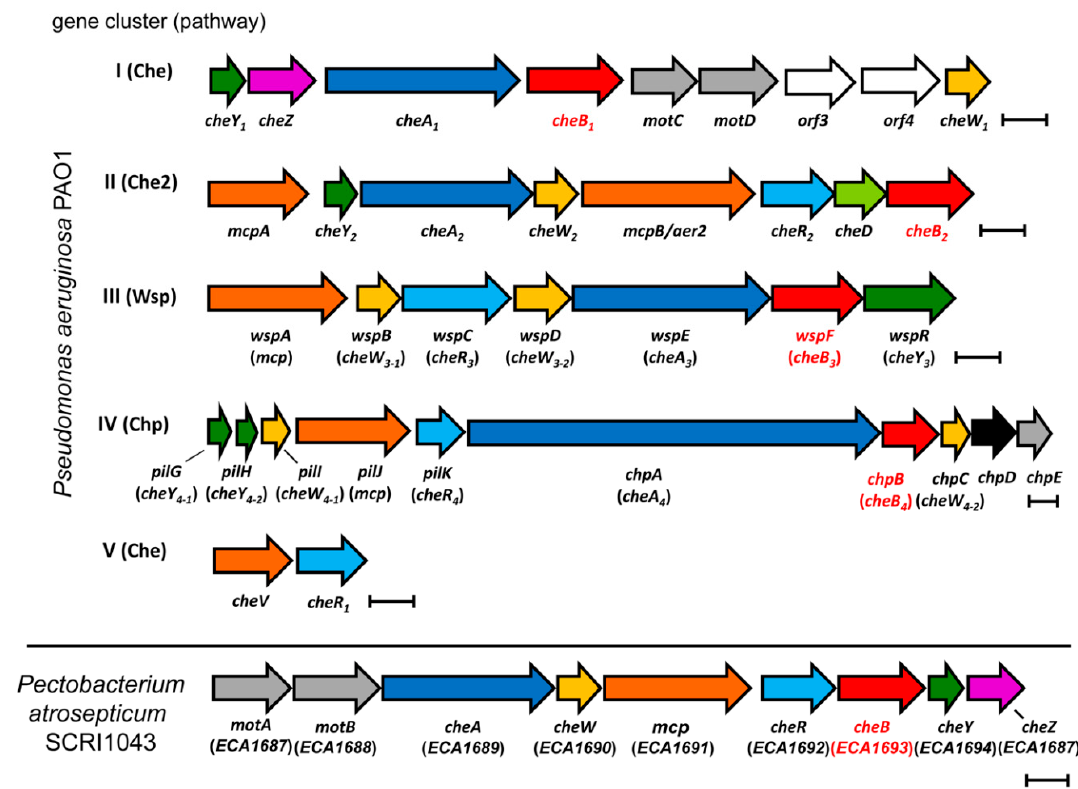
Figure 1. Gene clusters encoding chemosensory signaling proteins in Pseudomonas aeruginosa PAO1 and Pectobacterium atrosepticum SCRI1043. Genes of the same family are colored in the same color. The genes of the proteins studied in this article are shown in red. Bars, 0.5 kbp.